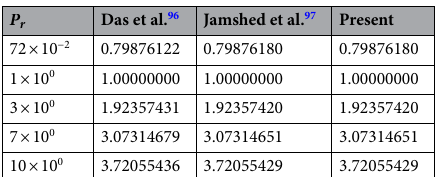
0 , 0 , φ 0 , φ 0 , E c = hnf = = =